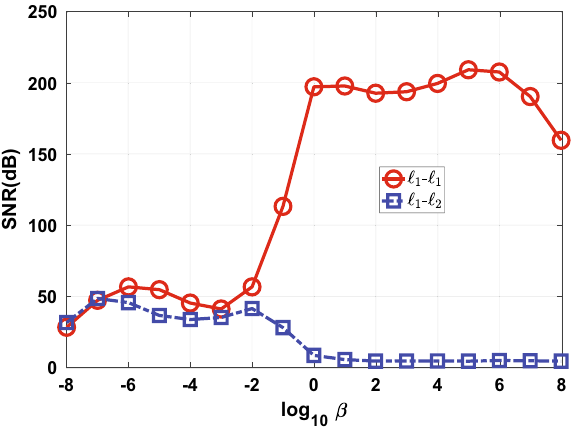
Fig. 2 Selection of the best β ’s for both the ℓ 1 – ℓ 1 model and the ℓ 1 – ℓ 2